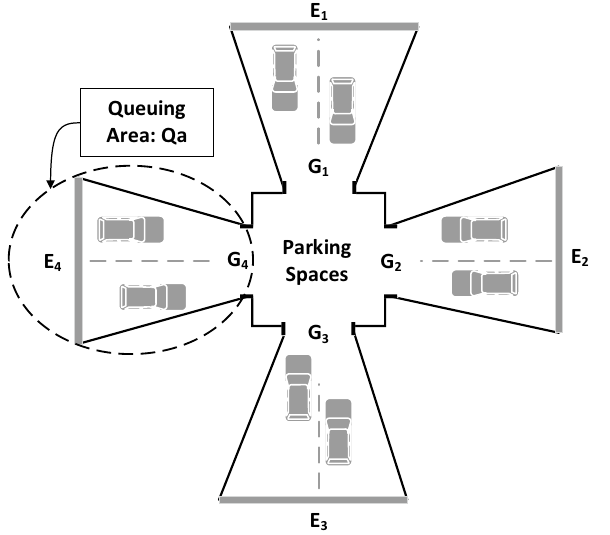
Figure 2. Entrance and queuing area